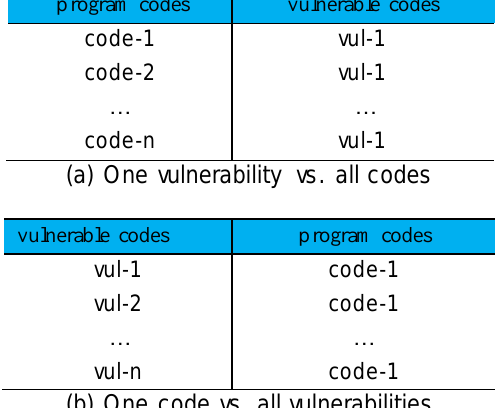
Figure 1. Two methods of code